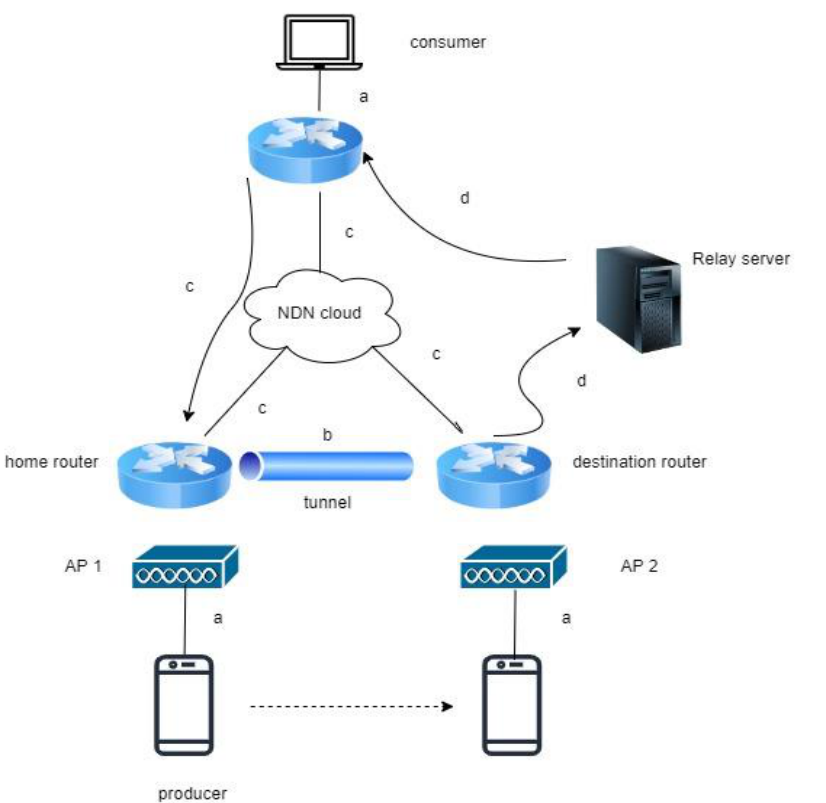
Figure 8. Network topology setup for KITE, the PMSS, and hybrid NeMO.